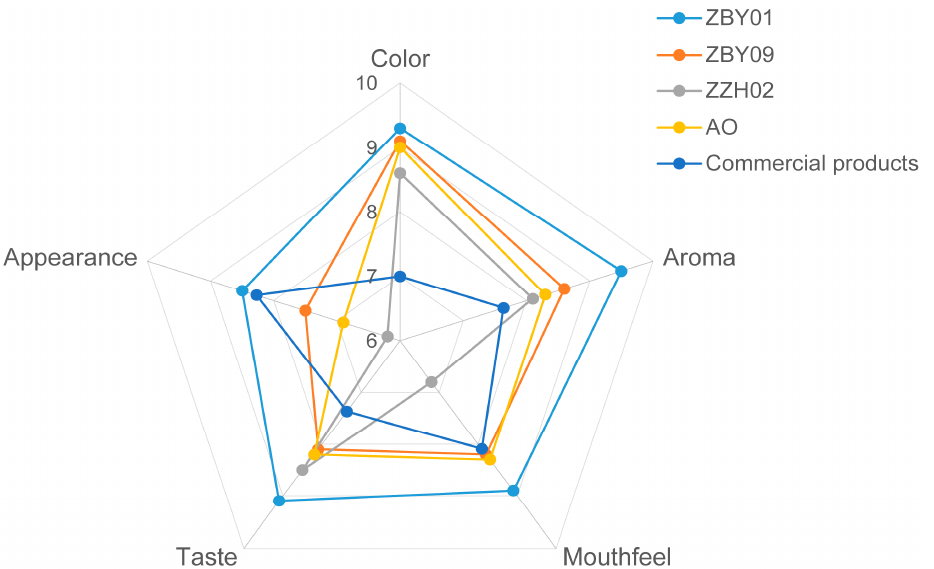
Figure 5. Sensory evaluation of oat milk.